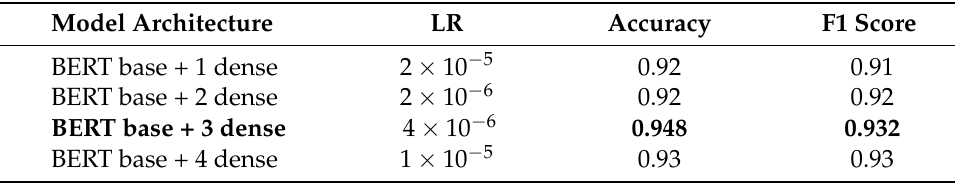
Table 2. Comparing different number of dense layers in fine-tuning CyBERT.